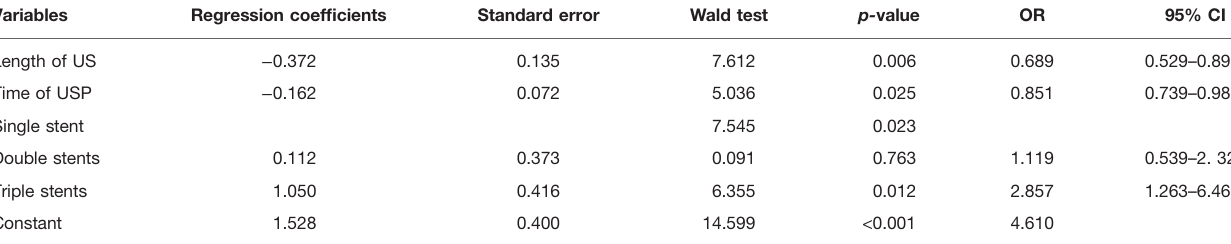
TABLE 3 | Risk factors related to the prognosis of patients at 6 months after stent removal using multivariate analysis.